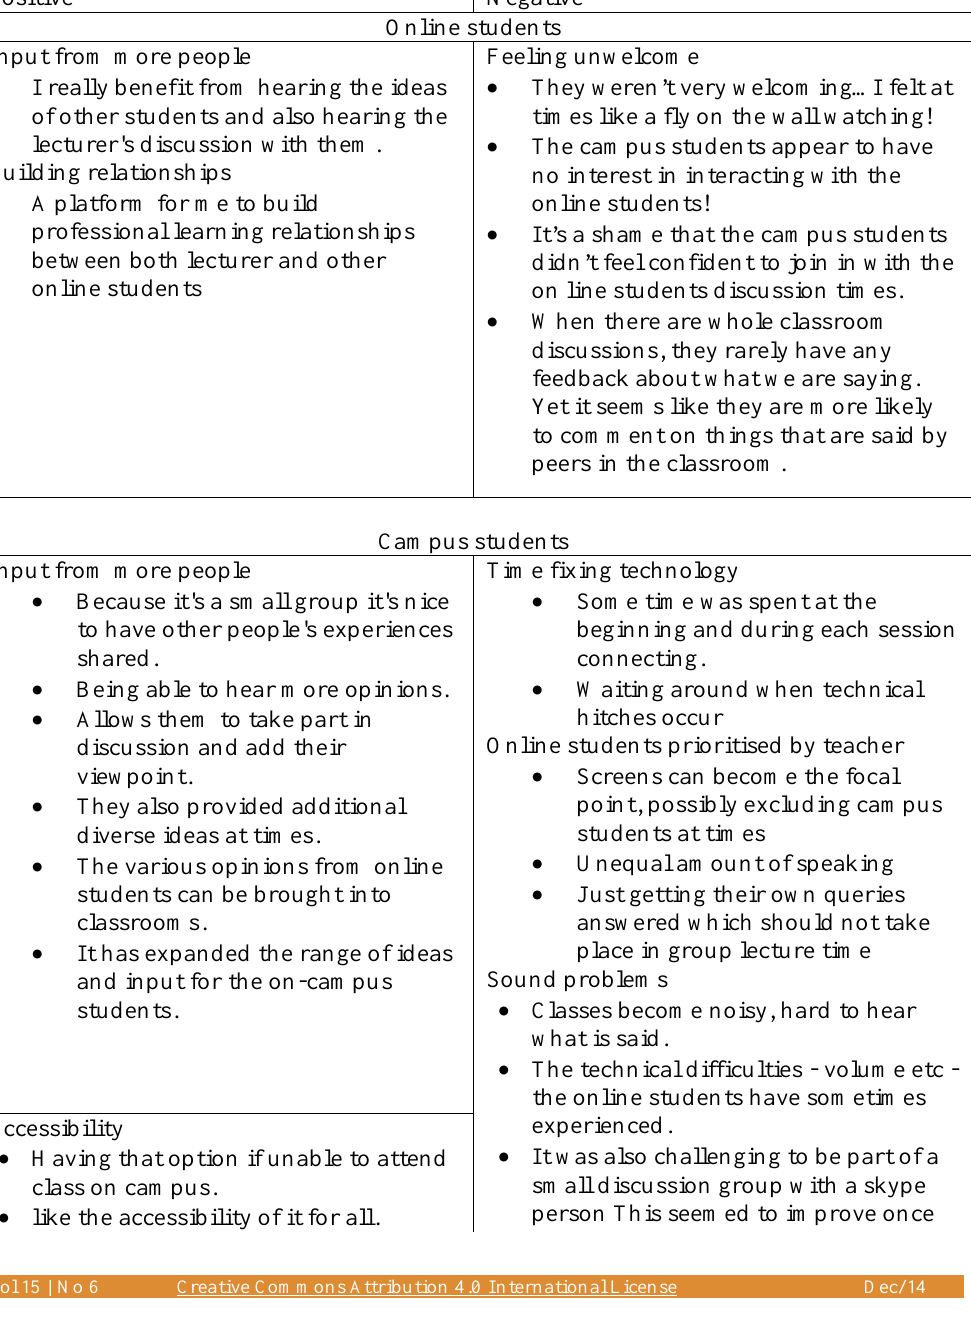
Summary of Students’ Experiences of Blended Synchronous Learning Positive Negative Online